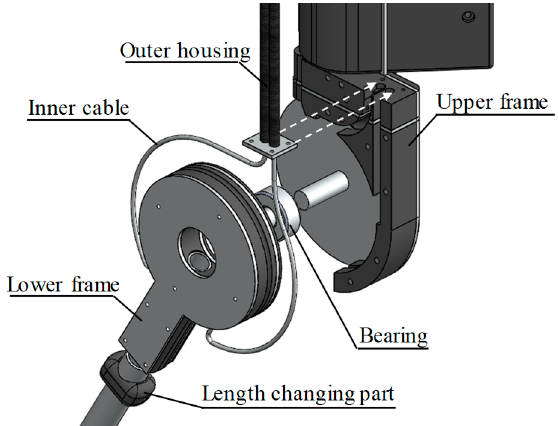
Figure 3. Exploded diagram of the driving section. The driving section is composed of an upper frame and a lower frame.